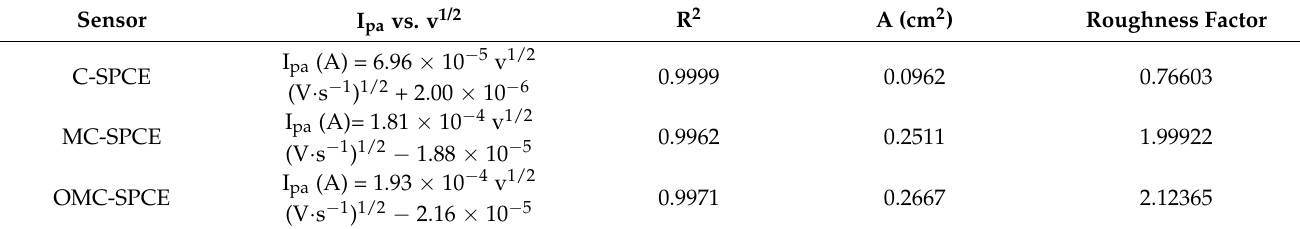
Table 2. Linear dependence equation, R 2 , active surface area and roughness factor for the three sensors. Sensor I pa vs. v